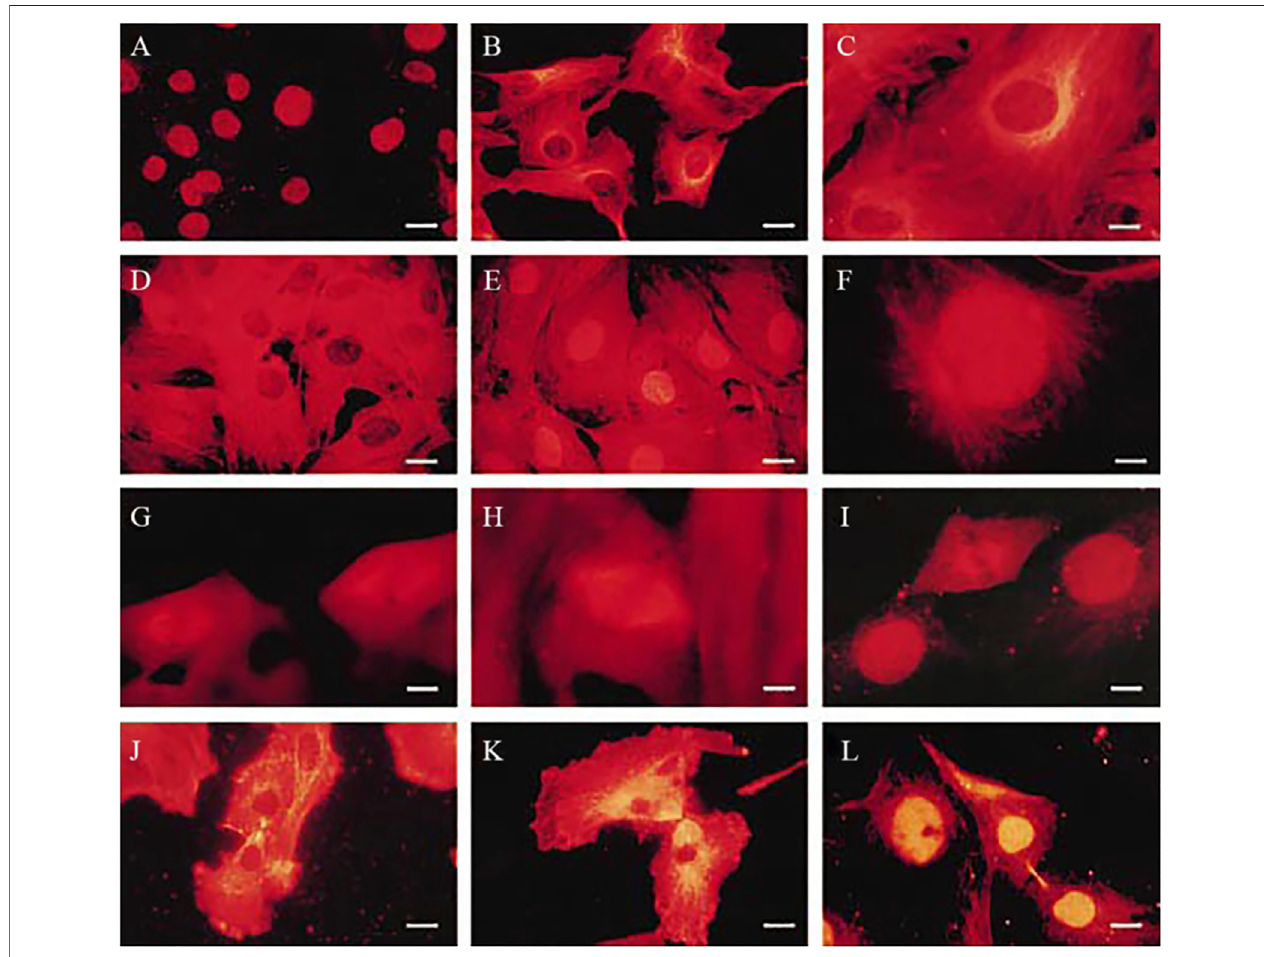
FIGURE 1 | Detection of ß -tubulin isotypes during the cell cycle of cultured rat kidney mesangial cells by indirect immuno fl uorescence. (A) Interphase cells treated with anti- ß II (0.03 mg/ml). Note that only the nuclei are stained. (B) Interphase cells treated with anti- ß I (0.1 mg/ml). Note very little staining in the nuclei. (C) Interphase cells treated with anti- β IV (0.17 mg/ml). Note very little staining in the nuclei. (D) Cells treated with 30 μ g/ml nocodazole, stained with anti- β I (0.1 mg/ml). Note widespread staining except in the nuclei. (E) Cells treated with 30 μ g/ml nocodazole, stained with anti- ß II (0.1 mg/ml). Note staining in the nuclei. (F) Cell during prophase,treatedwithanti- ß II(0.05 mg/ml).Notethatastersarebeginningtoformandthattheycontain ß II. (G) Cellsduringmetaphase,treatedwithanti- ß I(0.1 mg/ml). ß Iisinthespindle. (H) Cellduring metaphase, treatedwithanti- ß IV(0.17 mg/ml). ß IV isinthespindle. (I) Cellduringmetaphase,treatedwithanti- ß II(0.05 mg/ml). ß IIisin thespindle. (J) Cellduringlatetelophase,treatedwithanti- ß I(0.05 mg/ml). ß Iisnotinthere-forming nuclei. (K) Cellduringlatetelophase, treatedwithanti- ß IV(0.08 mg/ ml). ß IV is not in the re-forming nuclei. (L) Cell during late telophase, treated with anti- ß II (0.05 mg/ml). Note that the nuclei, staining brightly for ß II, have now re-formed. Bar = 28 μ m (From. Walss et al.,